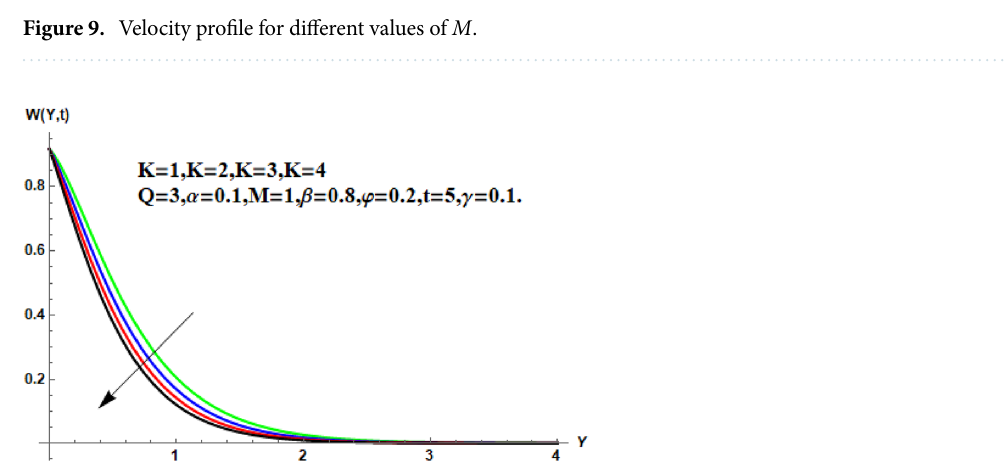
Figure 10. Velocity profile for different values of K